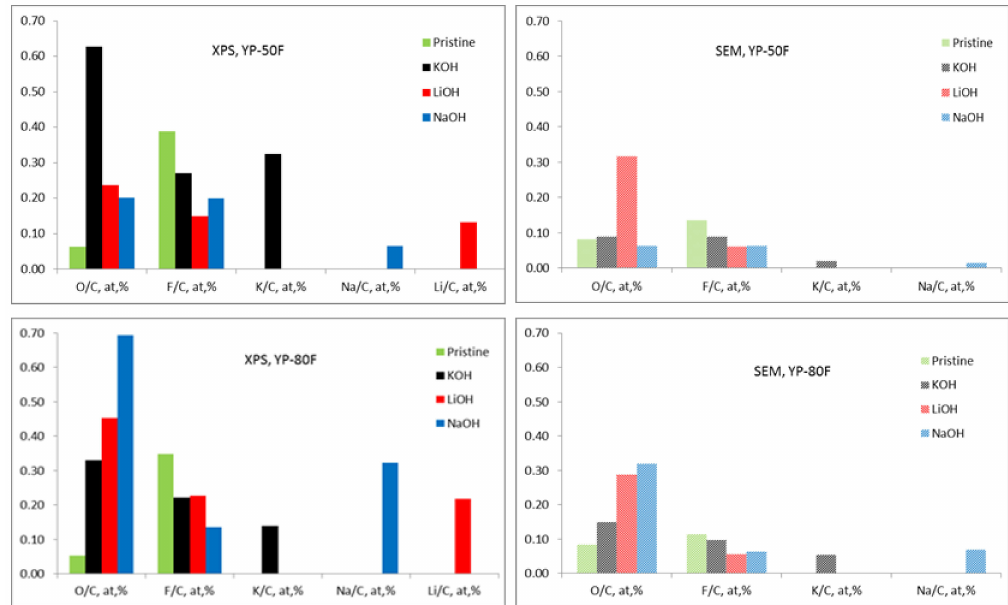
Figure 7. Element ratio (to carbon, at.%) for carbonaceous electrodes calculated from XPS and SEM / EDS data for pristine and worked electrodes in di ff erent electrolytes after 1000 cycles. (The origin of F is associated with the Teflon binding agent used. The amount of Li cannot be determined by SEM / EDS.).